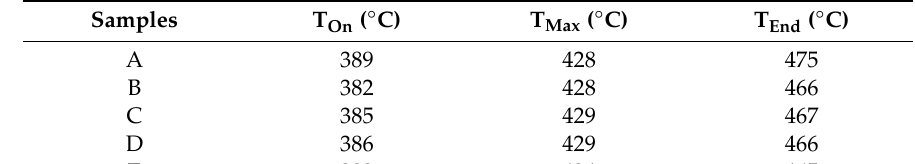
Table 3. Temperatures at onset (T On ), end (T End ) and maximum rate (T max ) of mass loss determined